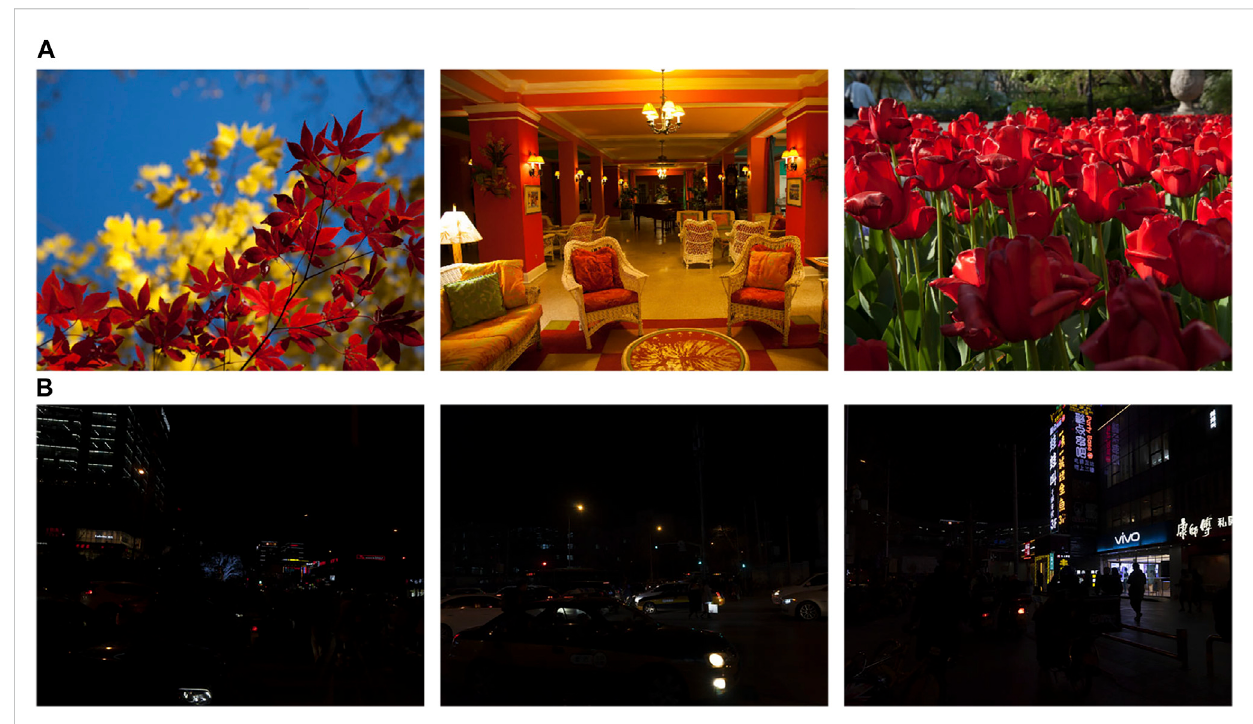
FIGURE 1 (A) The presentation of the existing synthetic LL dataset and (B) the real-world LL images. (A,B) shows the apparent domain gap in terms of illumination level and white balance lying between the real-world and the existing synthetic LL